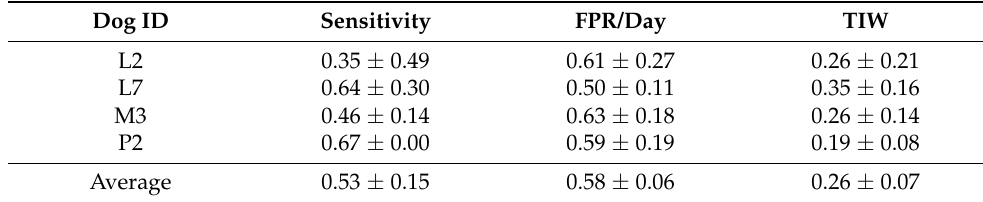
Table 4. Average prediction performance using interictal data randomly selected from the whole training pool (five